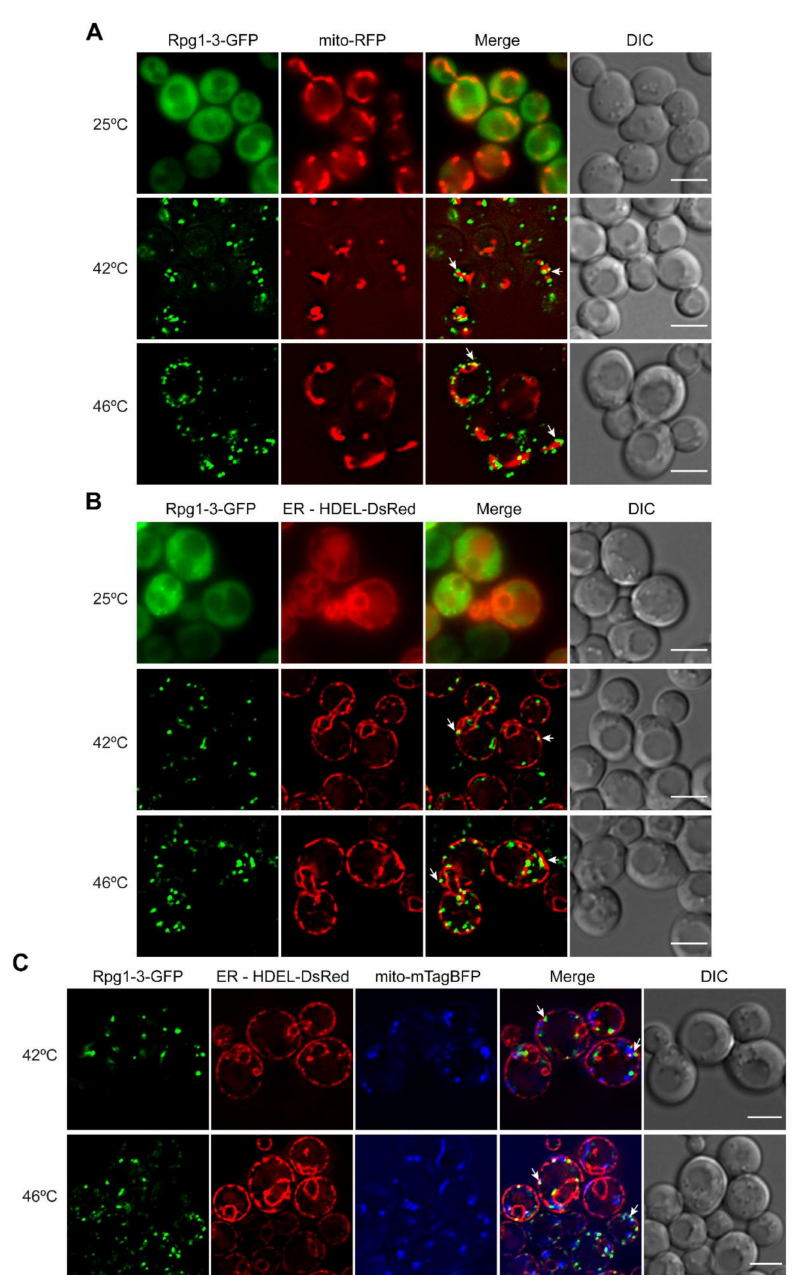
Figure 5. Association of HS SGs with mitochondria and ER. Live-cell imaging of exponentially growing cells at 25 ◦ C and heat-shocked at 42 ◦ C for 30 min or 46 ◦ C for 10 min carrying Rpg1-3-GFP with ( A ) mito-RFP (mitochondrial marker) or ( B ) HDEL-DsRed (ER marker). ( C ) Distribution of Rpg1-3-GFP-decorated SGs at both temperatures in cells with simultaneously labeled mitochondria (mito-mTagBFP) and ER (HDEL-DsRed). White arrows point to HS SGs associating with organelles. Single layers of Z-stacks are presented for unstressed cells, and single layers of Z-stacks after deconvolution with the AMLE filter (Xcellence software, Olympus) are shown as HS images. Scale bars, 5 µ